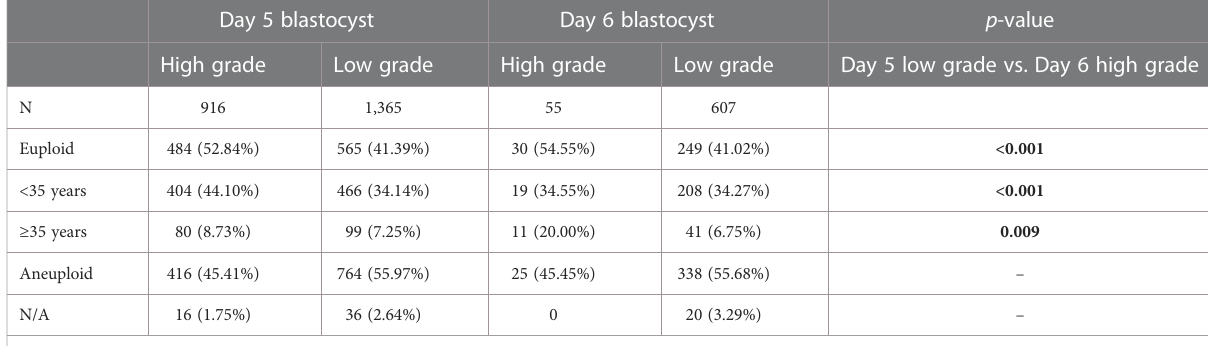
Chi-square for categorical variables. Statistically signi fi cant values are highlighted in bold. N/A, Not